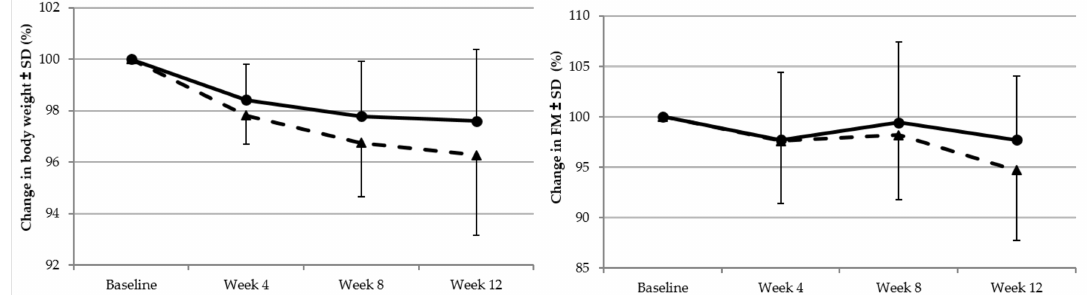
Figure 2. Baseline adjusted mean body weight and body fat changes from baseline at weeks 4, 8, and 12 for the participants consuming isomaltulose (triangles, dotted lines) or sucrose (circles, solid